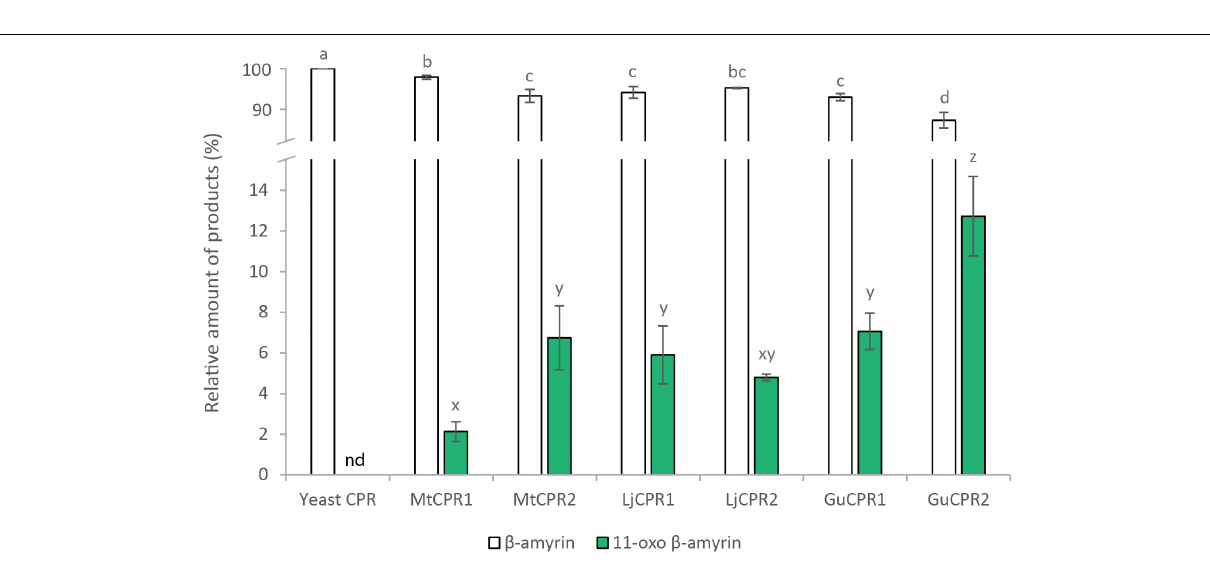
Frontiers in Plant Science |